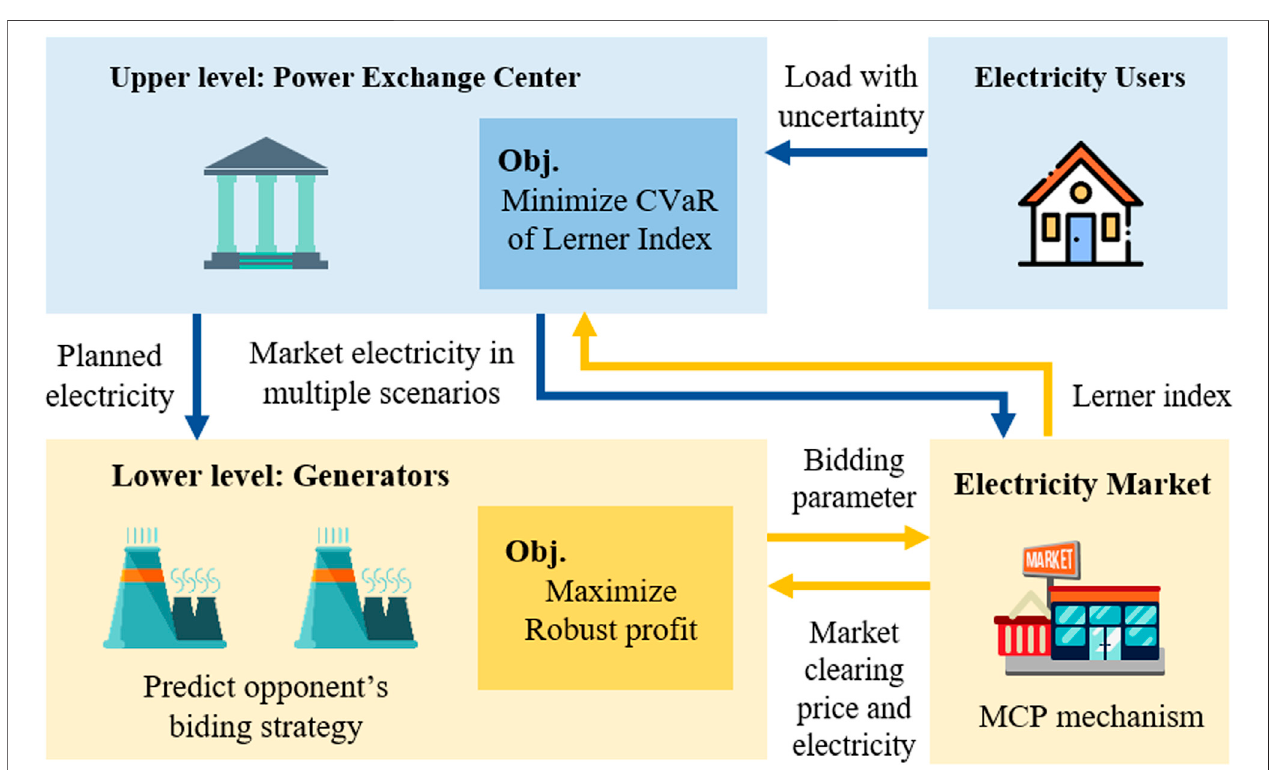
FIGURE 2 | Schematic diagram of the bi-level model of planned electricity